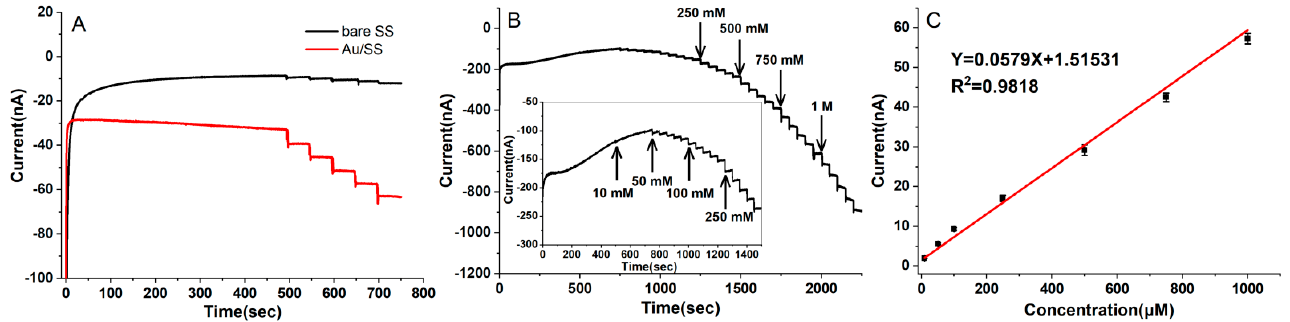
Figure 4. ( A ) Amperometric response of the bare SS and Au/SS wire-based electrochemical microsensor to successive additions of 10 µL H 2 O 2 with concentration100 mM in 10 mL solution with 0.2 M PBS (pH 7) at − 0.6 V application potential. ( B ) Amperometric response of the Au/SS wire-based electrochemical microsensor to successive additions of 10 µL H 2 O 2 with concentration 10 mM, 50 mM, 100 mM, 250 mM, 500 mM, 750 mM, and 1000 mM, respectively, in 10 mL solution with 0.2 M PBS (pH 7) at − 0.6 V application potential. ( C ) Linear relation between the amperometric response and H 2 O 2 concentration ranging from 10 µM to 1000 µM ( n = 5).